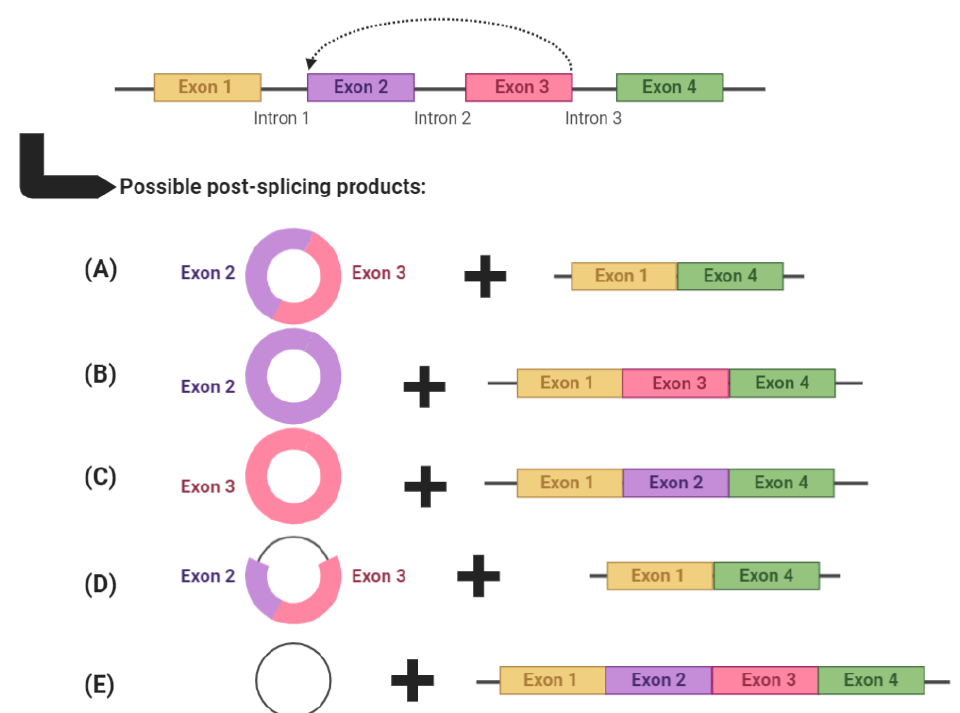
Figure 1. An example of circRNA biogenesis using backsplicing. circRNAs are produced through backsplicing and can potentially produce several alternatively spliced products. circRNAs can: ( A ) comprise multiple exons, ( B , C ) comprise a single exon, ( D ) comprise both exons and introns (termed exonic intronic circRNAs) or ( E ) comprise only introns (termed circular intronic RNAs). After each backsplicing event, the remaining exons are left to form an alternatively spliced transcript. Graphic created with BioRender.com, accessed on 5 May 2021.